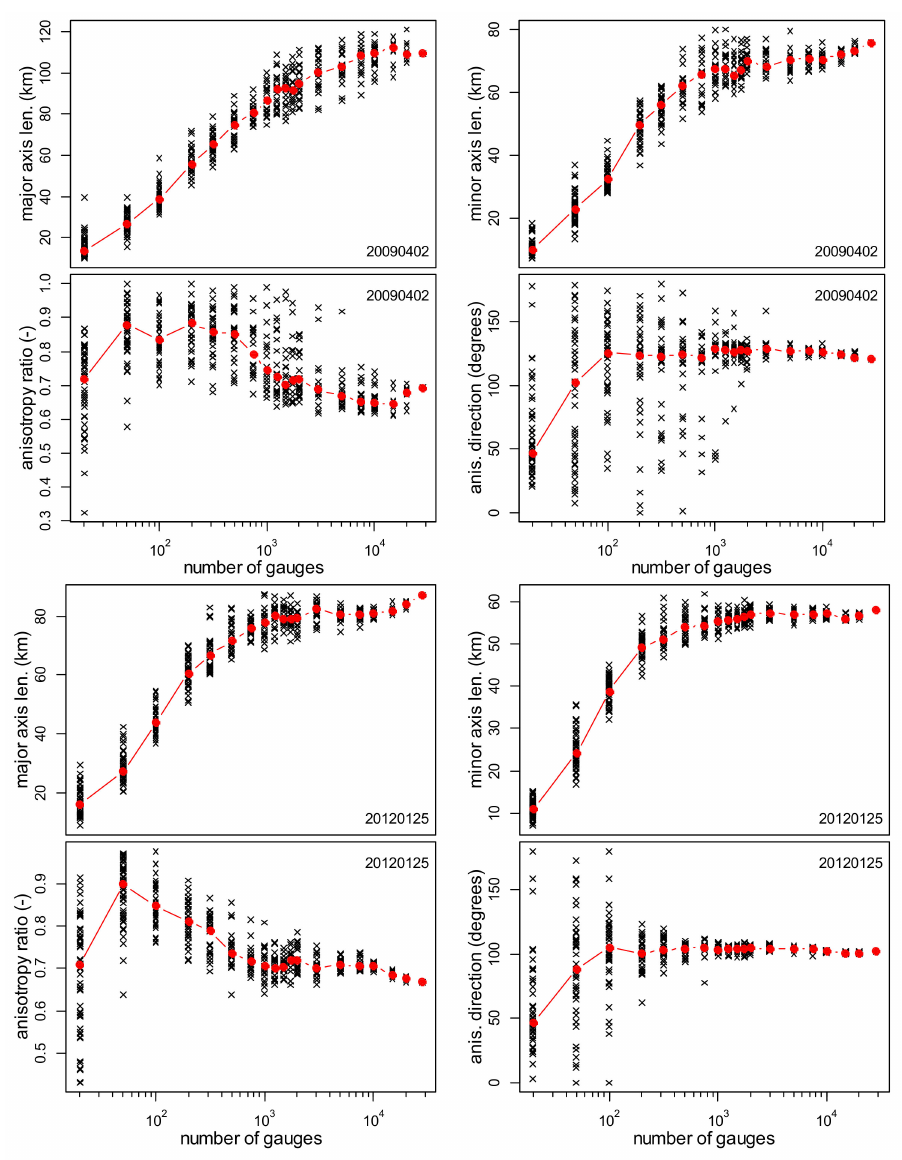
Figure 7. Variation of the correlogram parameters with the number of rainfall gauges; the crosses are values for the repeated stratified sampling and the solid circles are the